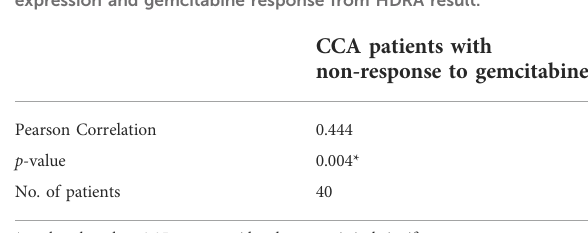
TABLE4Pearsoncorrelationcoef fi cientsbetweenIHCscoresofIL-6R expression and gemcitabine response from HDRA